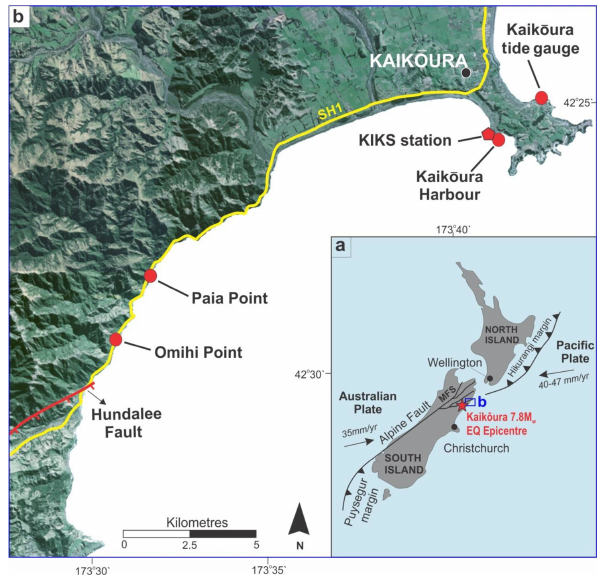
Figure 1. (a) Inset map of New Zealand illustrating the main tectonic features of the Hikurangi subduction margin, the loca- tion of the Marlborough Fault System (MFS) and the epicentre of the 2016 M w = 7 . 8 Kaik¯oura earthquake. The blue box near the Kaik¯oura earthquake epicentre indicates the study area. (b) Map showing the study localities from which Durvillaea and Carpophyl- lum holdfast measurements were recorded using RTK GNSS and tape measure, the position of State Highway 1 (SH1) from which lidar data points were derived (see yellow line), the location of the Kaik¯oura tide gauge, and the KIKS strong-ground-motion station. The Hundalee Fault is also located. The background image is sup- plied by Land Information New